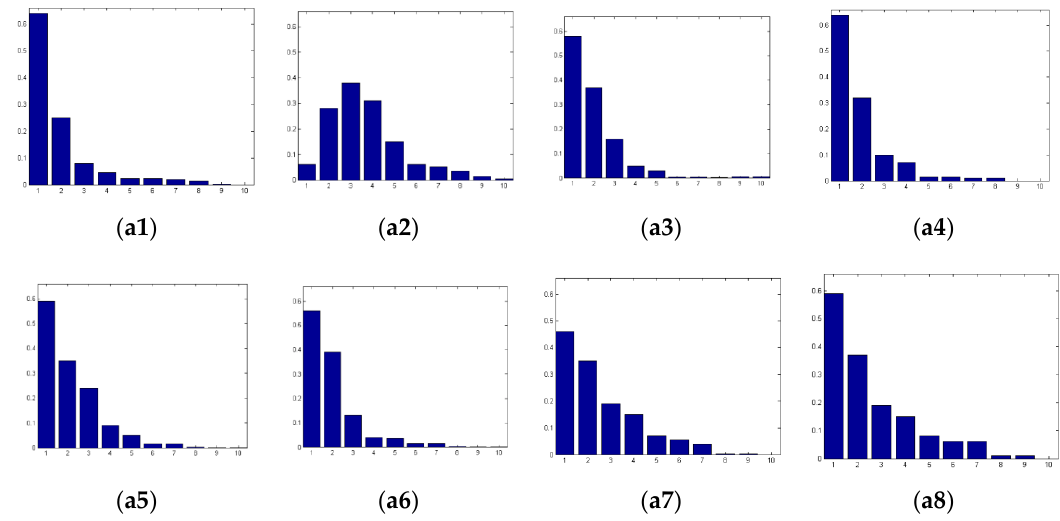
Figure 9. The examples of luminance features of pictorial regions; (a1 – a8 ) are the histograms of MSCN values of pictorial regions contained in the corresponding subgraphs ( a1 – a8 ) of Figure 5.